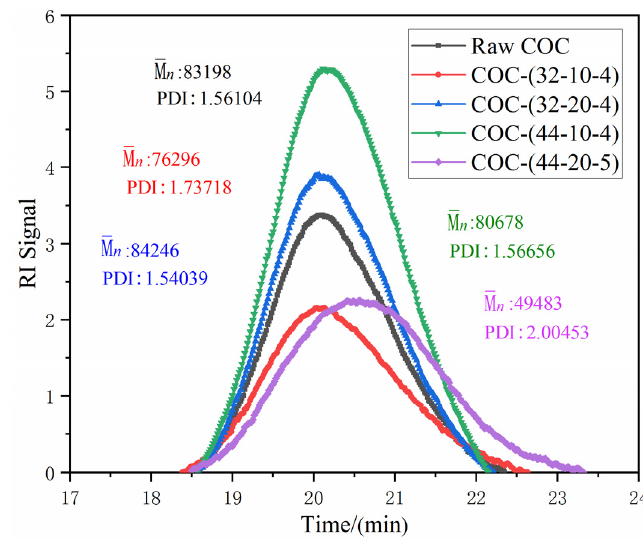
Figure 10. Molecular weight distribution curves of raw COC and processed COC samples under the following parameter combinations: (1) 32-10-4; (2) 32-20-4; (3) 44-10-4; (4) 44-20-5. Nomenclature: amplitude ( µ m); plasticizing pressure (MPa); time (s).